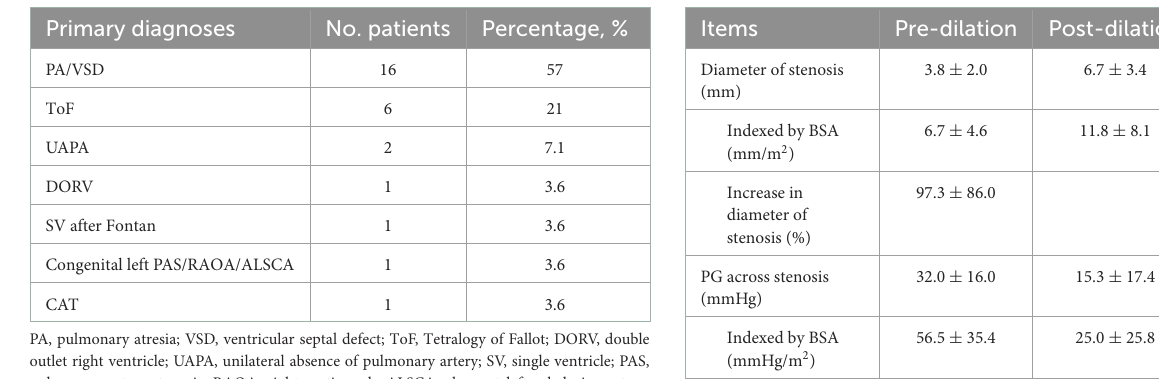
TABLE 1 Primary diagnoses of patients.